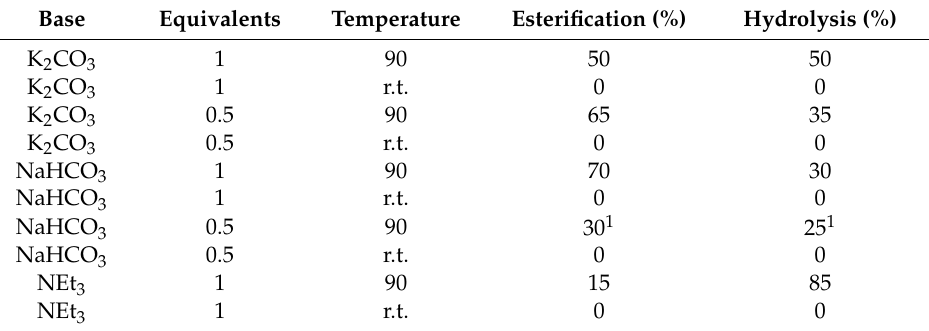
Table 1. Evaluated reaction conditions in the esterification process.